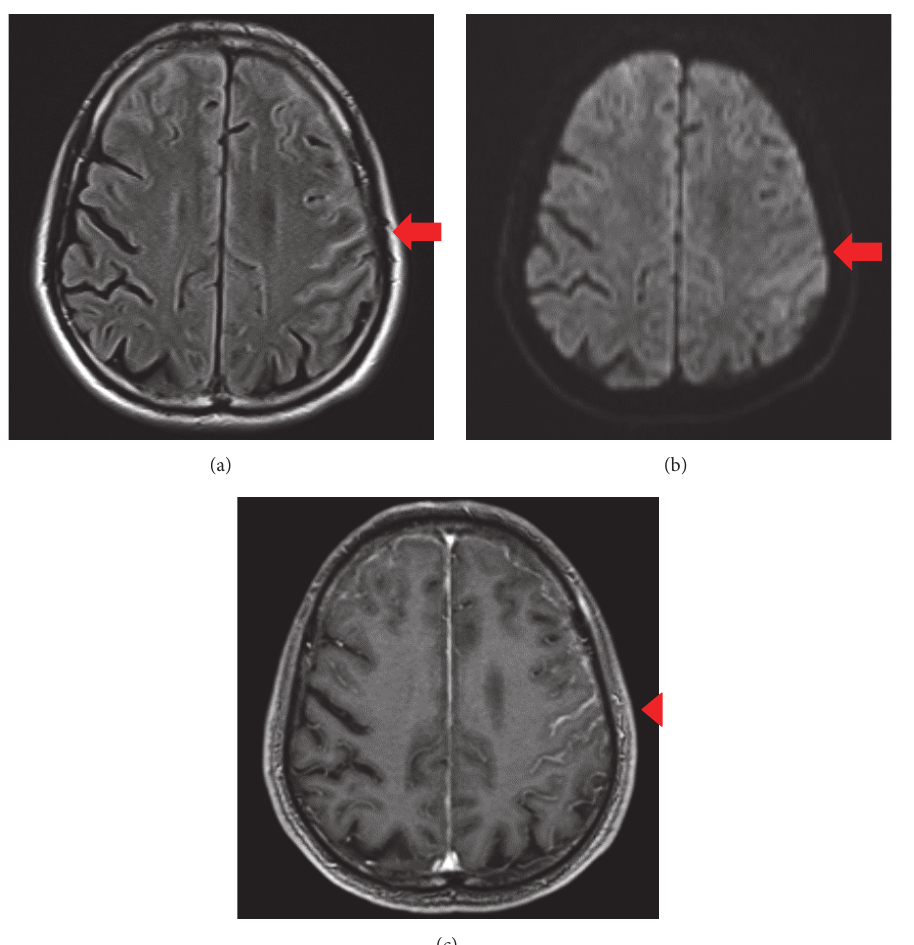
Figure 2: Brain MRI findings on the 4th admission. (a) Axial T2 fluid-attenuated inversion recovery (FLAIR) image (1.5 T; TR 10000 ms, TE 108 ms). (b) Diffusion-weighted image (DWI) (1.5 T; TR 5000 ms, TE 75 ms). (c) T1-weighted image (T1WI) enhanced by gadolinium (1.5T; TR 7.50ms, TE 2.82 ms). MRI shows extensive thick linear hyperintensity of the leptomeninges in bilateral frontal lobe and the left parietal lobe on T2 FLAIR and DWI (red arrows). T1WI after gadolinium administration shows enhancement of the leptomeninges (red arrowhead).